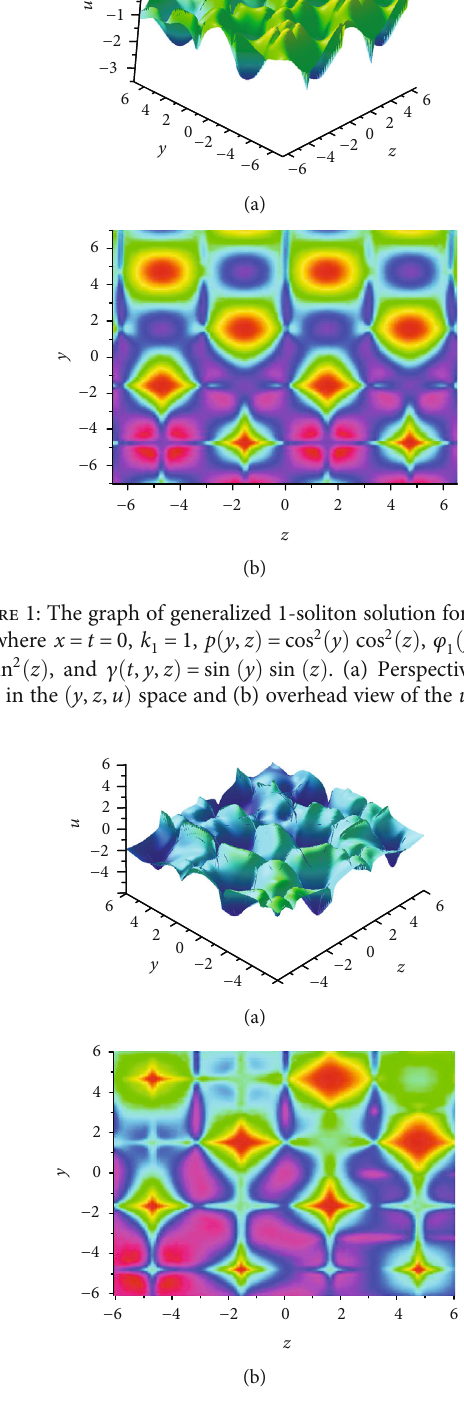
Figure 2: The graph of generalized 2-soliton solution for Eq.(4), where x = t = 0 , k 1 = 2 , k 2 = 1 , p ð y , z Þ = cos 2 ð y Þ cos 2 ð z Þ , φ 1 ð y , z Þ = = ð y , z Þ = exp ð z Þ sin 2 ð y Þ , and γ ð t , y , z Þ = sin ð y Þ exp ð y Þ sin 2 ð z Þ , φ 2 sin ð z Þ . (a) Perspective view of the u in the ð y , z , u Þ space and (b) overhead view of the u